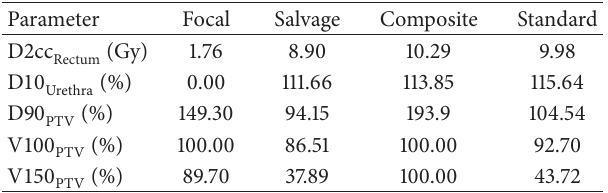
Table 3: Experimental dose to target and OAR between focal, salvage, and whole gland HDR